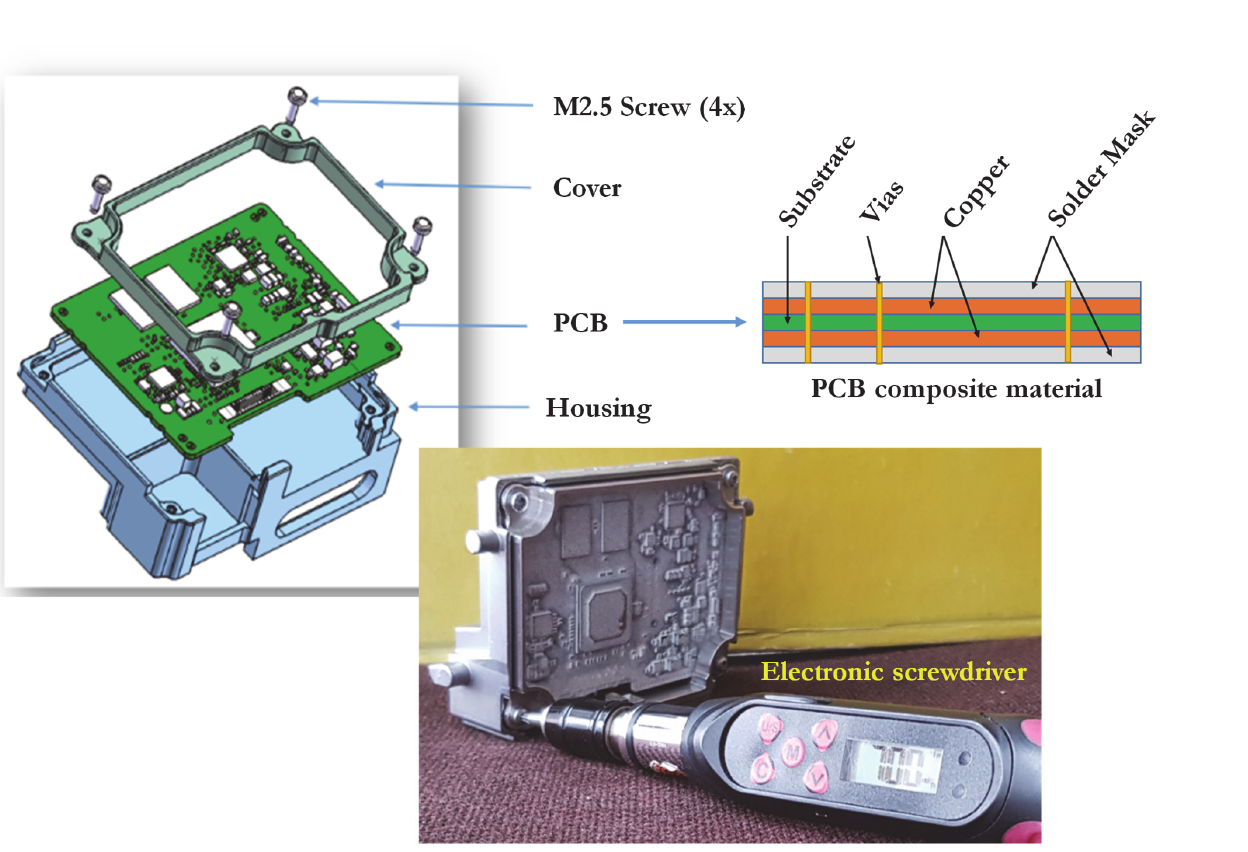
Figure 2: PCB composite material and experimental